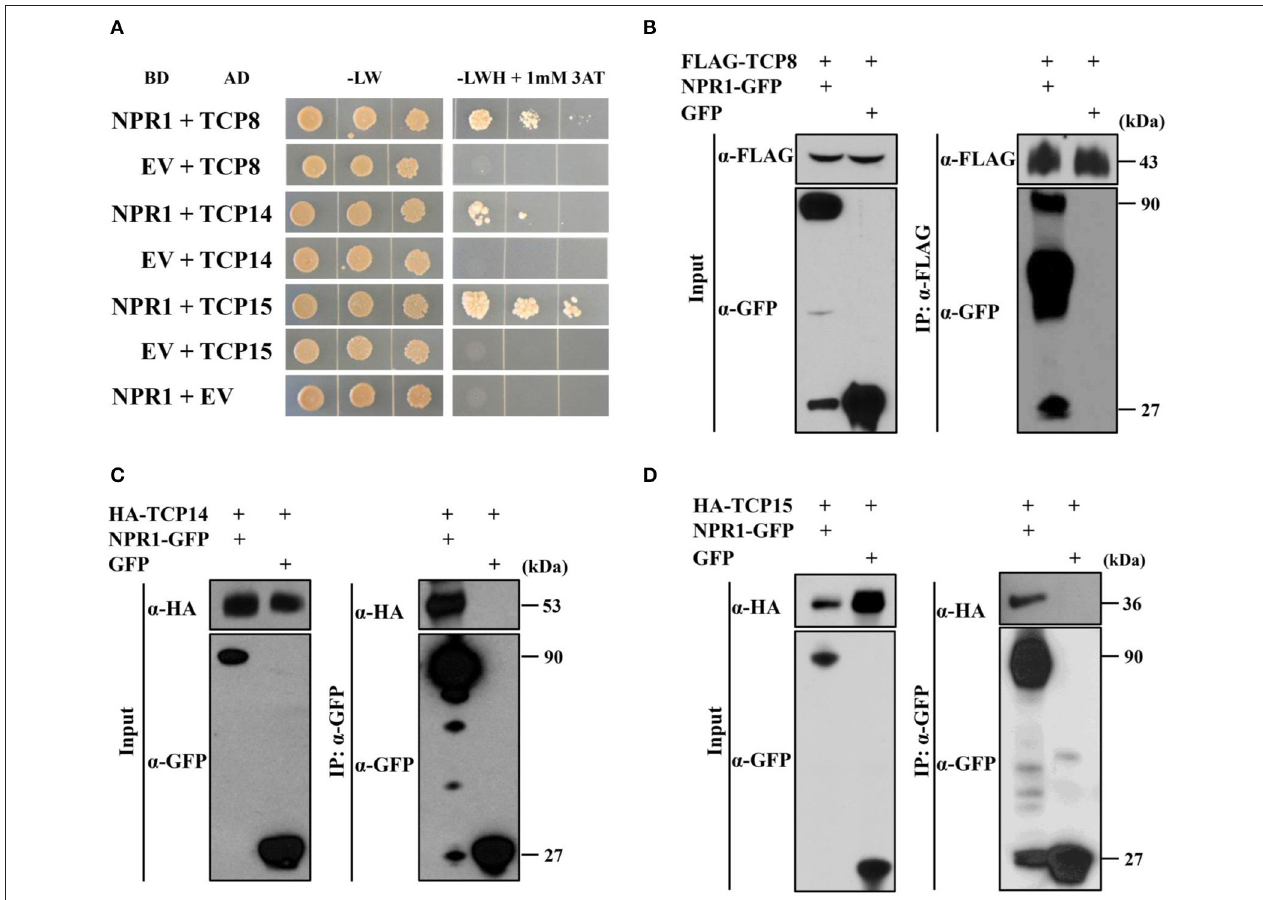
FIGURE 1 | TCP8, TCP14, and TCP15 interact with NPR1. (A) Interactions between NPR1 with TCP8, TCP14, and TCP15 in yeast two-hybrid assays. Diploid yeast cells were serially diluted at OD 600 = 1.0, 0.1, and 0.01. Aliquots of 10 µ L of each dilution were plated on double synthetic dropout control plates without leucine